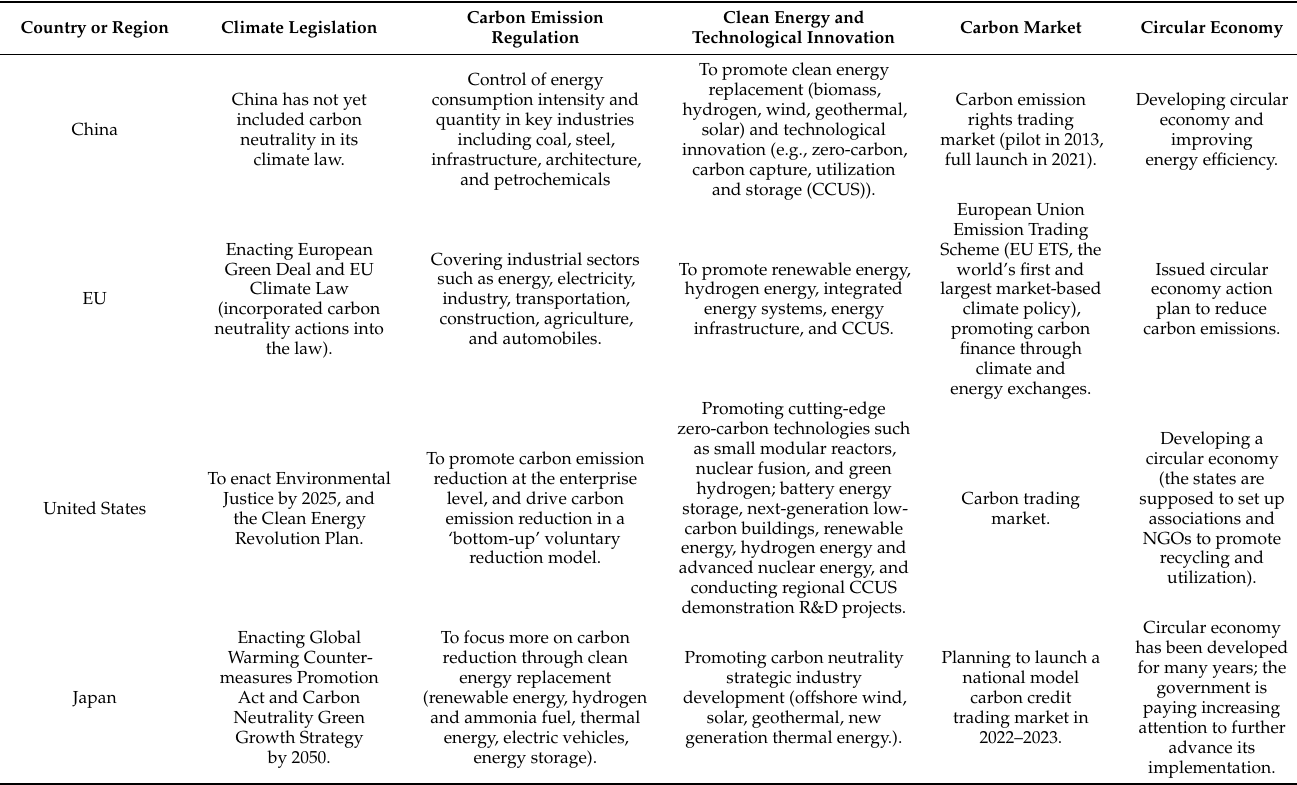
Table 1. Carbon neutrality policy comparison between China and other major CO 2